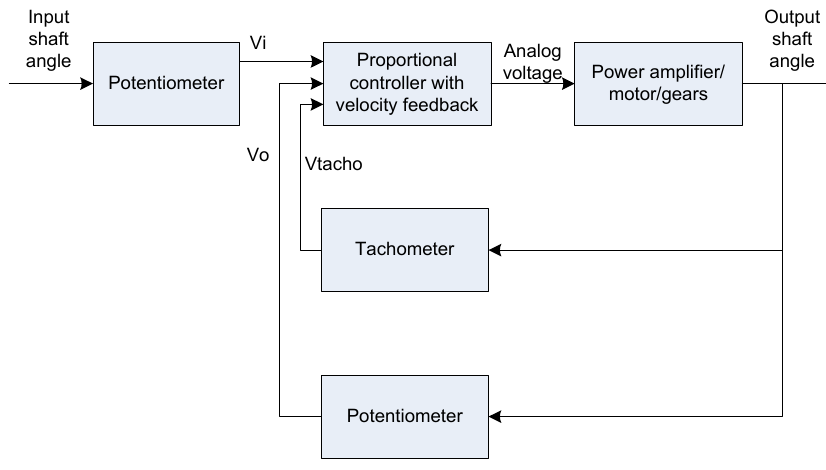
Fig. 6. Position control system with operational amplifier-based velocity feedback controller